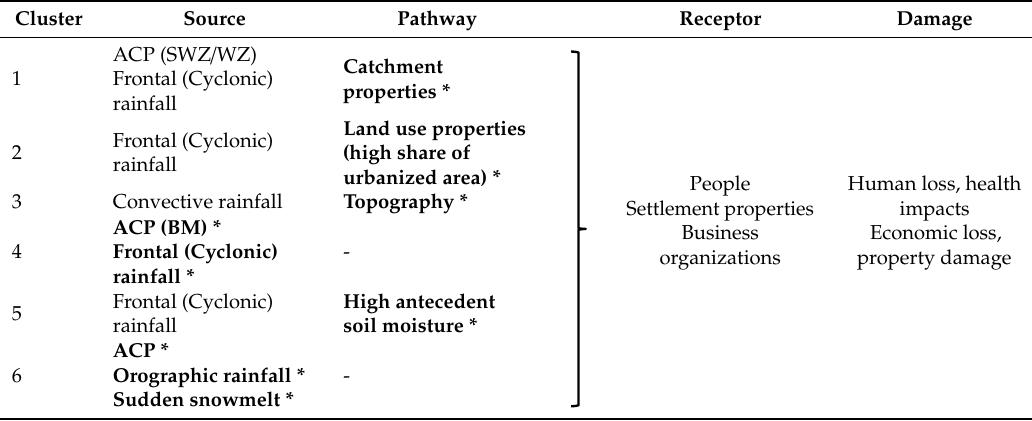
Table 6. Source–Pathway–Receptor–Consequence (SPRC) model elements of the clusters.